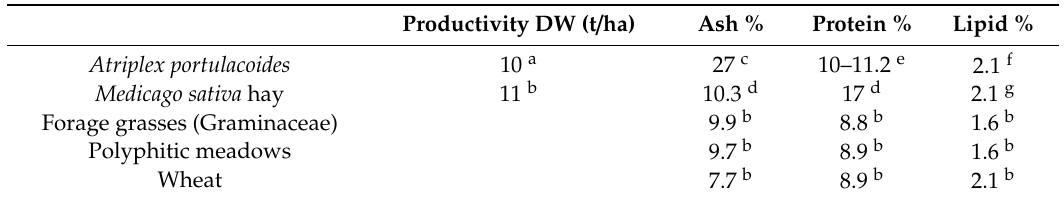
Table 3. Comparison of the productivity and composition of A. portulacoides and some typical forage